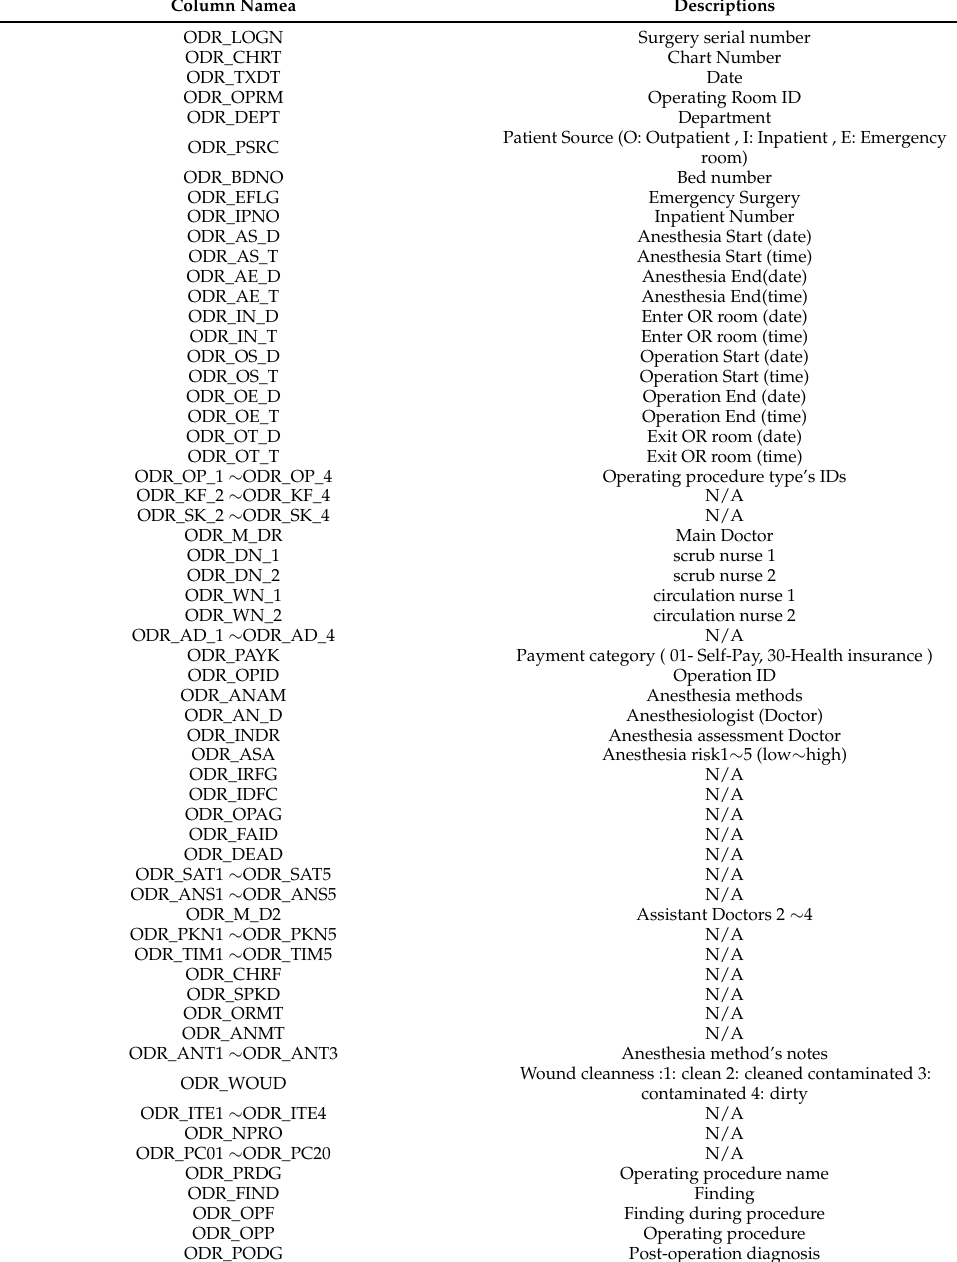
Table A1. Raw data feature columns with